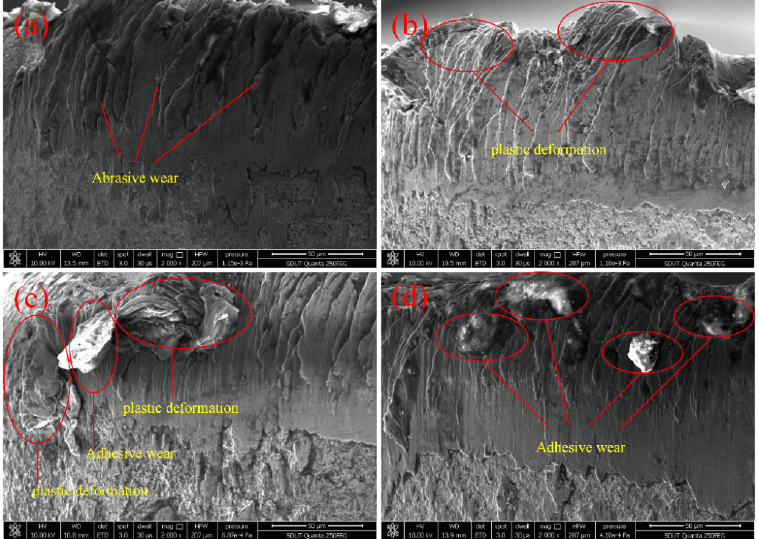
Figure 3. Tool morphology under dry machining at four cutting speeds: ( a ) 30 m/min, ( b ) 40 m/min, ( c ) 50 m/min, and ( d ) 60 m/min.